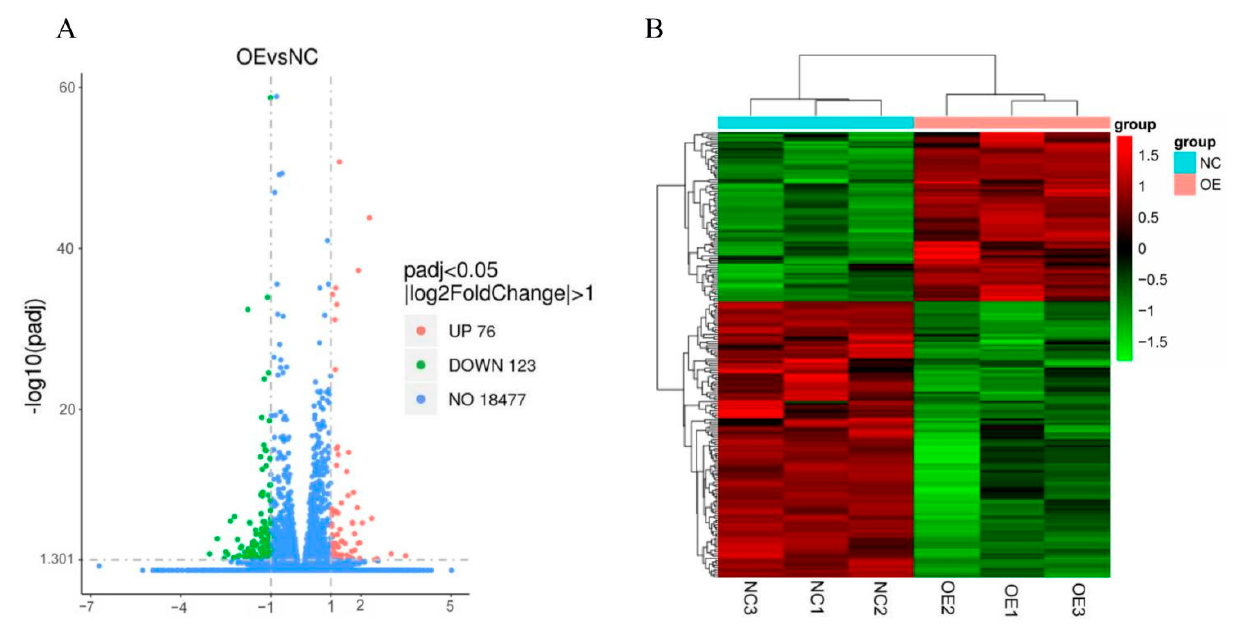
Figure 3. Analysis of DEGs between two groups of RNA-Seq data. ( A ) Volcano plots of DEGs between overexpressed QKI and negative control (NC). Red and green dots represent upregulated and downregulated genes, respectively, in OE group compared with NC group. ( B ) Heatmap of hierarchical cluster analysis of DEGs between samples. The horizontal coordinates are the sample names and the vertical coordinates are the normalized values of the differential gene FPKM. The expression level increases with the deepening of red and decreases with the deepening of green.